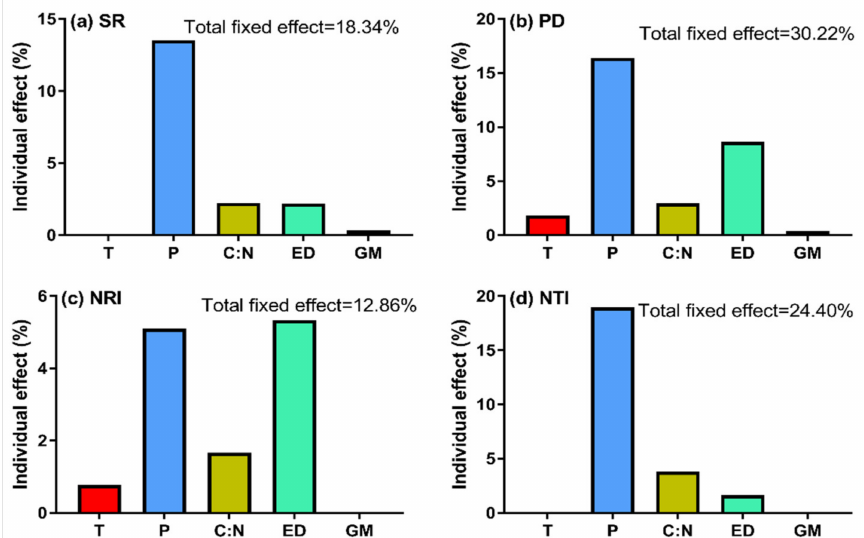
Figure 6. Relative contributions of GST, GSP, soil C:N ratio, enclosure duration f (ED, year) and grass- land management (GM, enclosure vs grazing) to the variation of ( a ) species richness (SR), ( b ) Faith’s phylogenetic diversity (PD), ( c ) net relatedness index (NRI), and ( d ) nearest taxon index